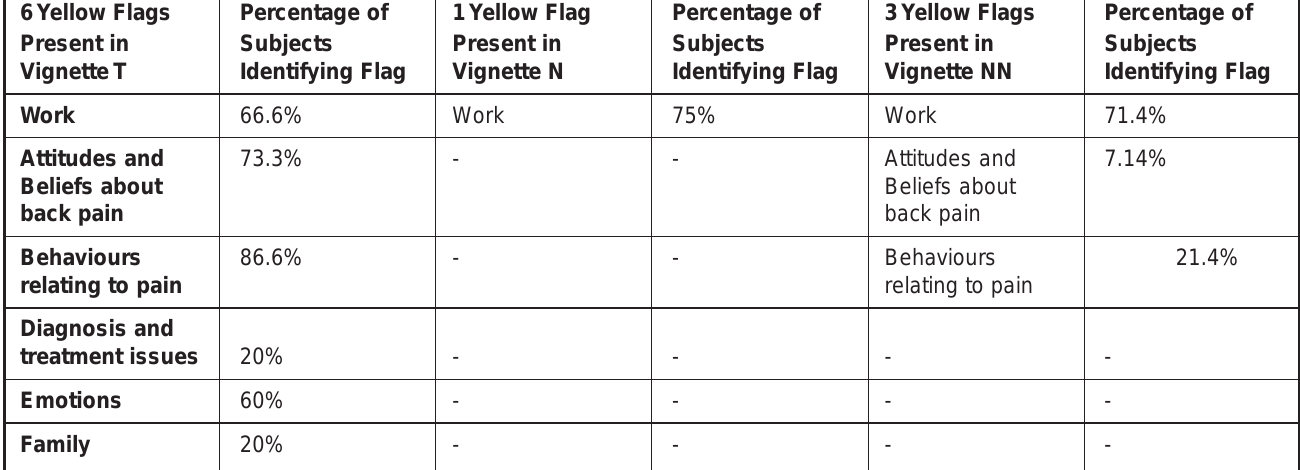
Table 4: Percentages of respondents identifying each yellow flag for each vignette.